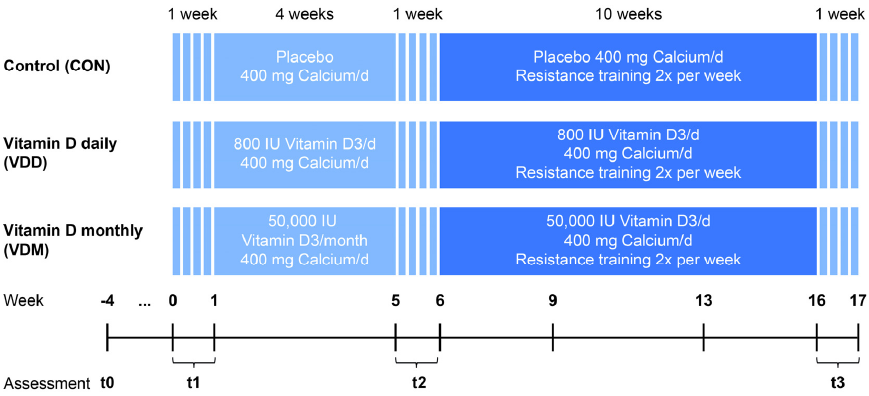
Figure 1. Study time